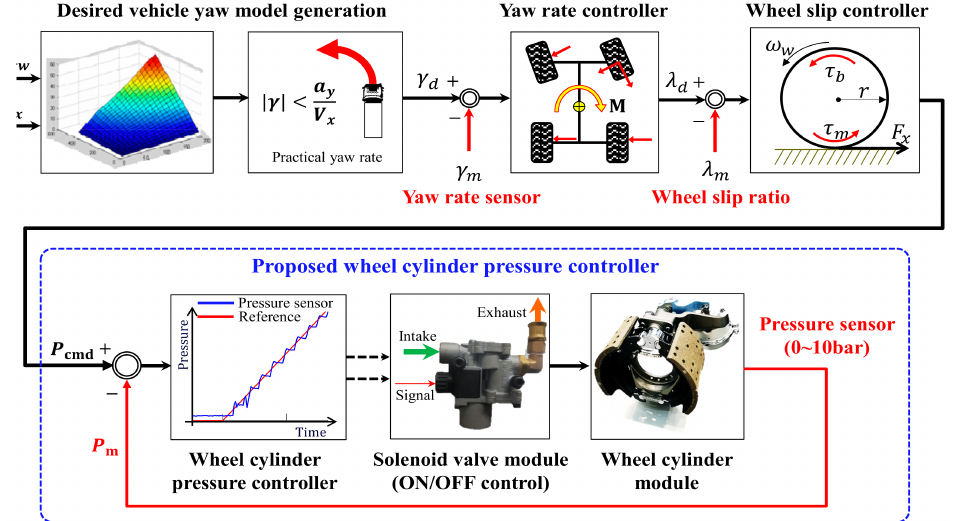
Figure 1. Schematic illustration of a commercial truck’s electronic stability control (ESC)